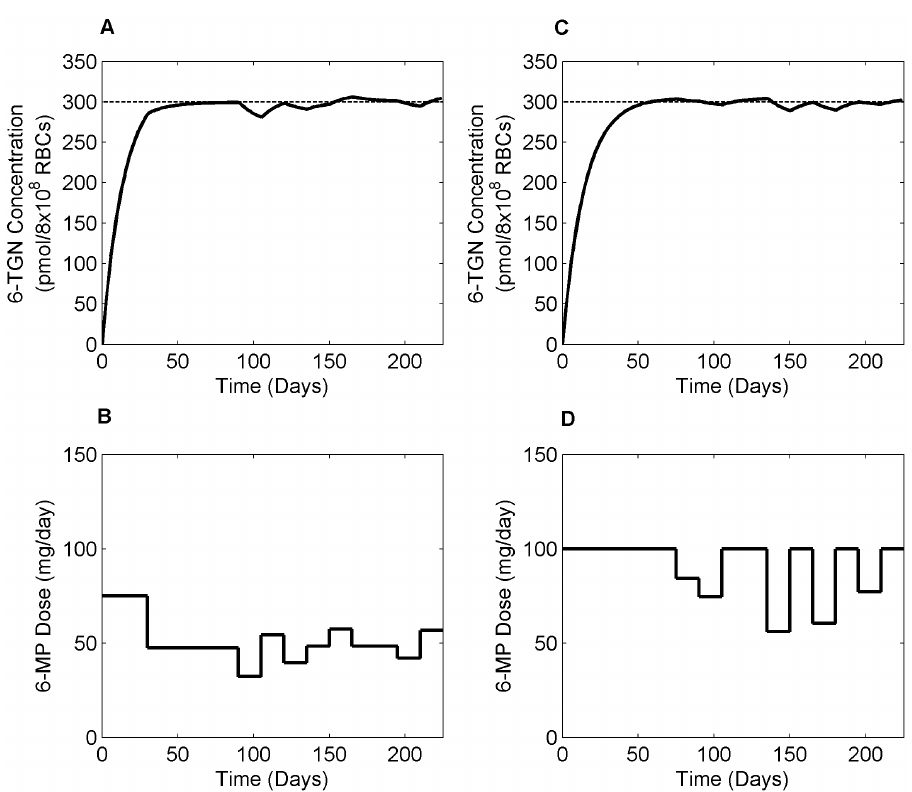
Figure 12. Optimal dosing based on 6-TGN concentration as therapeutic target. A & B. Optimal 6-TGN concentration and optimal 6-MP regimen respectively, for a patient with low TPMT enzyme activity. C & D. Optimal profiles for a patient with high TPMT enzyme activity. Patient with low TPMT activity required significantly lower dose compared to the standard treatment and vice versa. Dashed line shows the therapeutic target level.